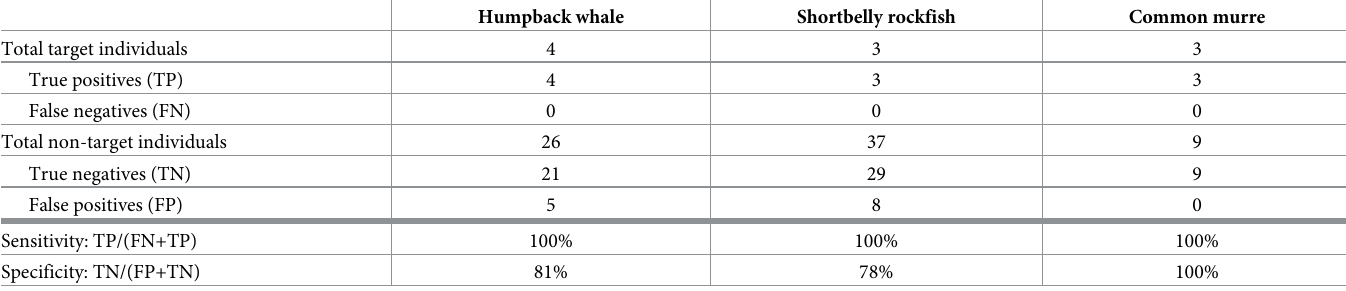
Table 3. Sensitivity and specificity of each